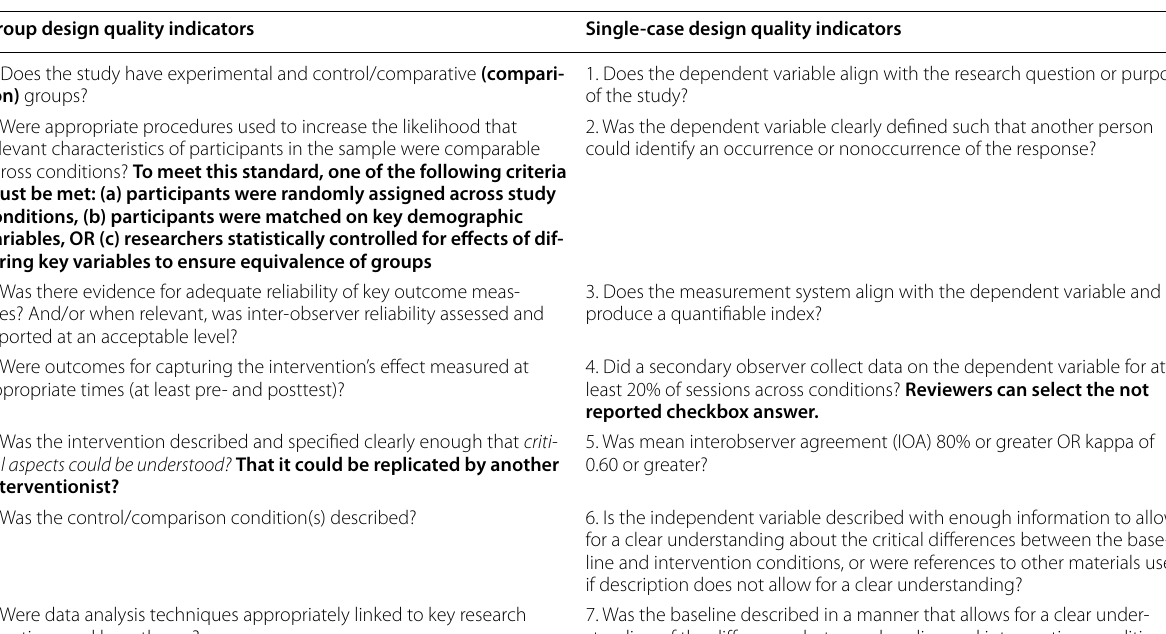
Table 7 was adapted from the assessment forms on the quality of evidence presented in Appendix 2 of NPDC’s synthesis report (2014) and Appendix 1 of NCAEP’s report (2020). Boldface text refers to the contents present only in NCAEP’s (2020) version; ATD , alternating treatment design. Instructions for filling the form have been described only on NPDC’s (2014) report (“instructions: read each item and check the appropriate box. If you check “NO” at any time, the article will not be included as evidence for a practice”). In the NCAEP’s (2020) version, a checkbox with the answer “Not reported” was included in some